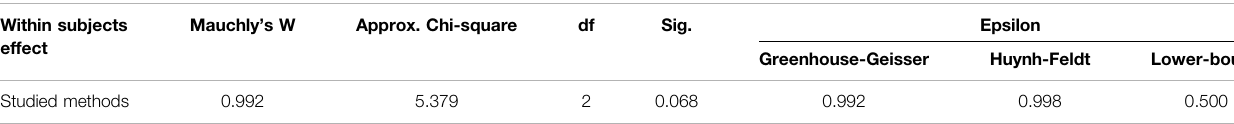
TABLE 6 | Mauchly ’ s test of sphericity.